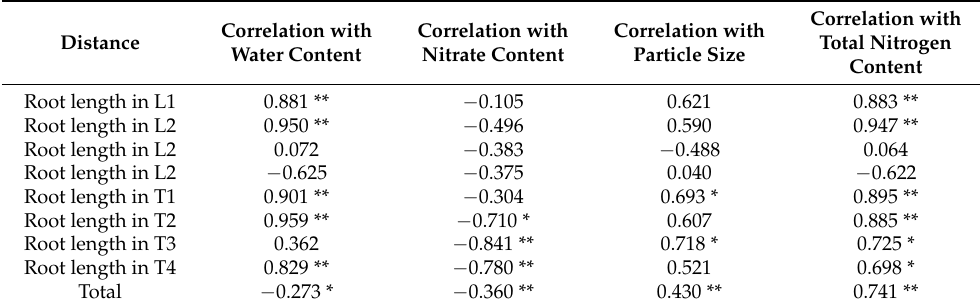
Table 1. Correlation of the root system, with the moisture content, nitrate content, and particle size in the apple root region. Distance